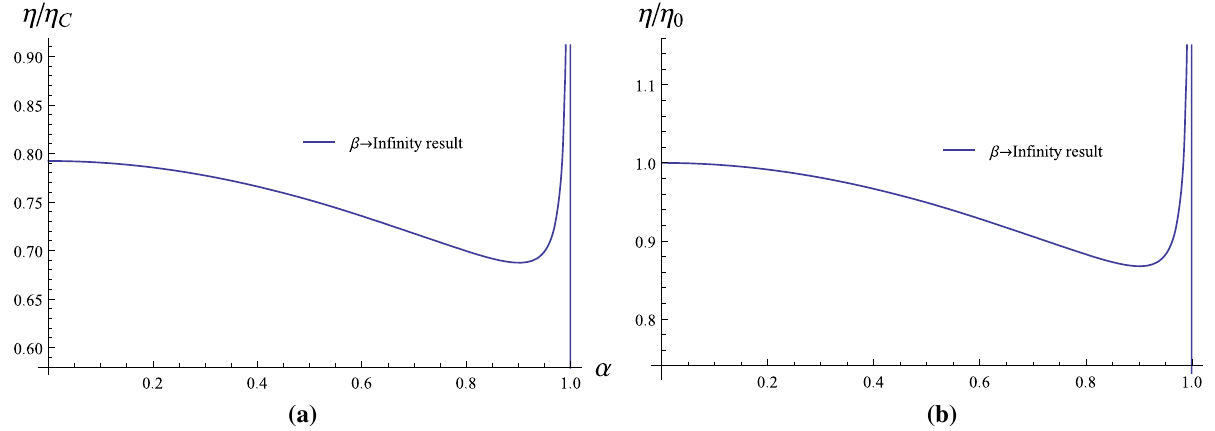
Fig. 6 In the limit β → ∞ . a The ratio η/η C vs. α. b The ratio η/η 0 vs α (see the caption of Fig. 2 for parameter values)